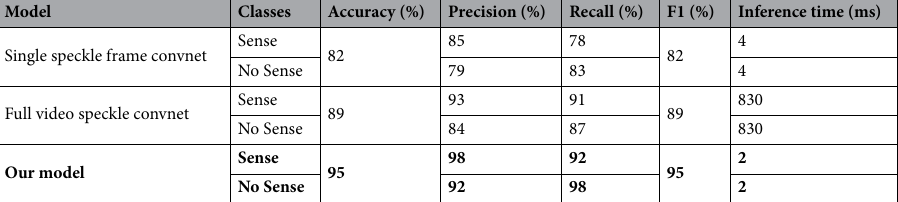
Table 1. Speckle-based DNN comparison. Our method reaches an accuracy of 95% while maintaining a high recall of 98% in active-sense classification task. In an active-sense classification task, the full video approach